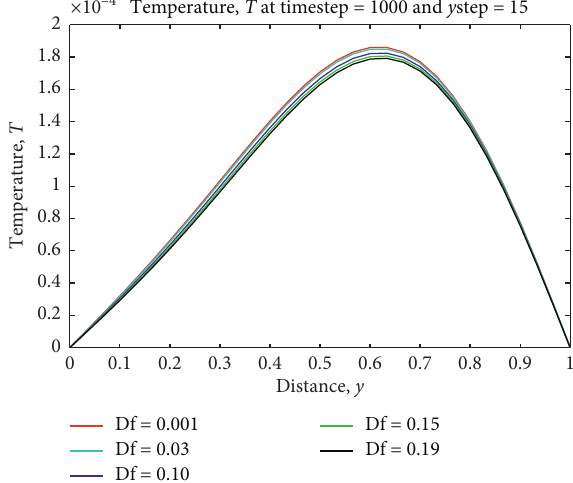
Figure 15: Effects of Prandtl number on temperature profile.